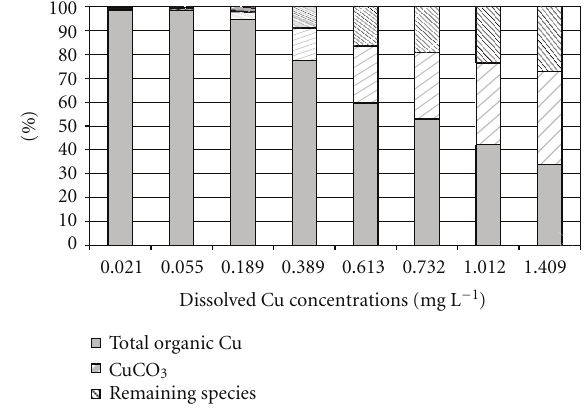
Figure 4: BLM speciation output for each of the copper concen- trations tested and control group (first column). Copper species are expressed as percentages of total dissolved copper concentra- tion. Remaining species summarizes the contributions of CuOH, − 2 , CuCl + , and CuHCO 3+ Cu(OH) 2 , CuSO 4 , Cu(CO 3 ) 2